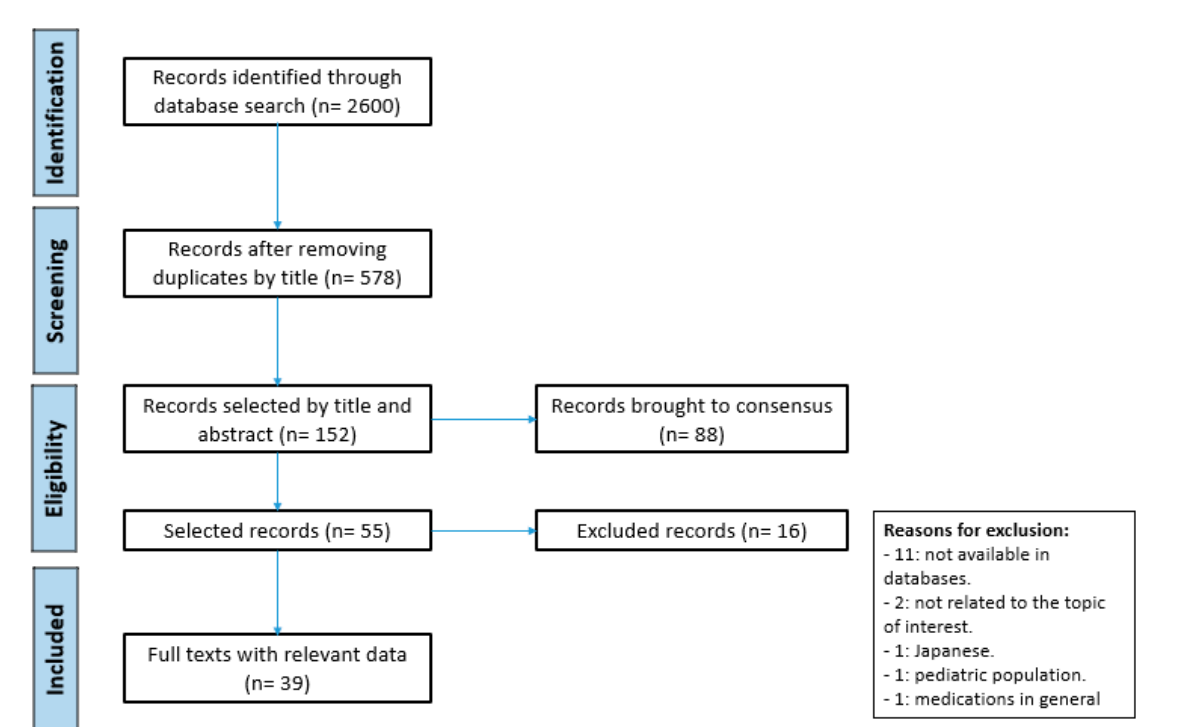
Figure 1. Study selection process according to PRISMA guidelines.